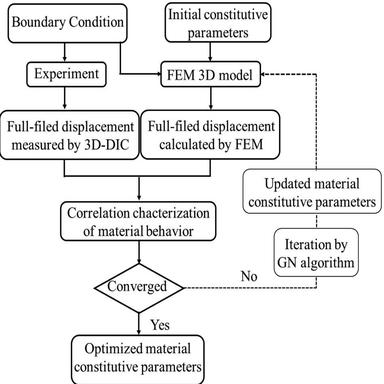
Flow-chart of the material property characterization procedure.